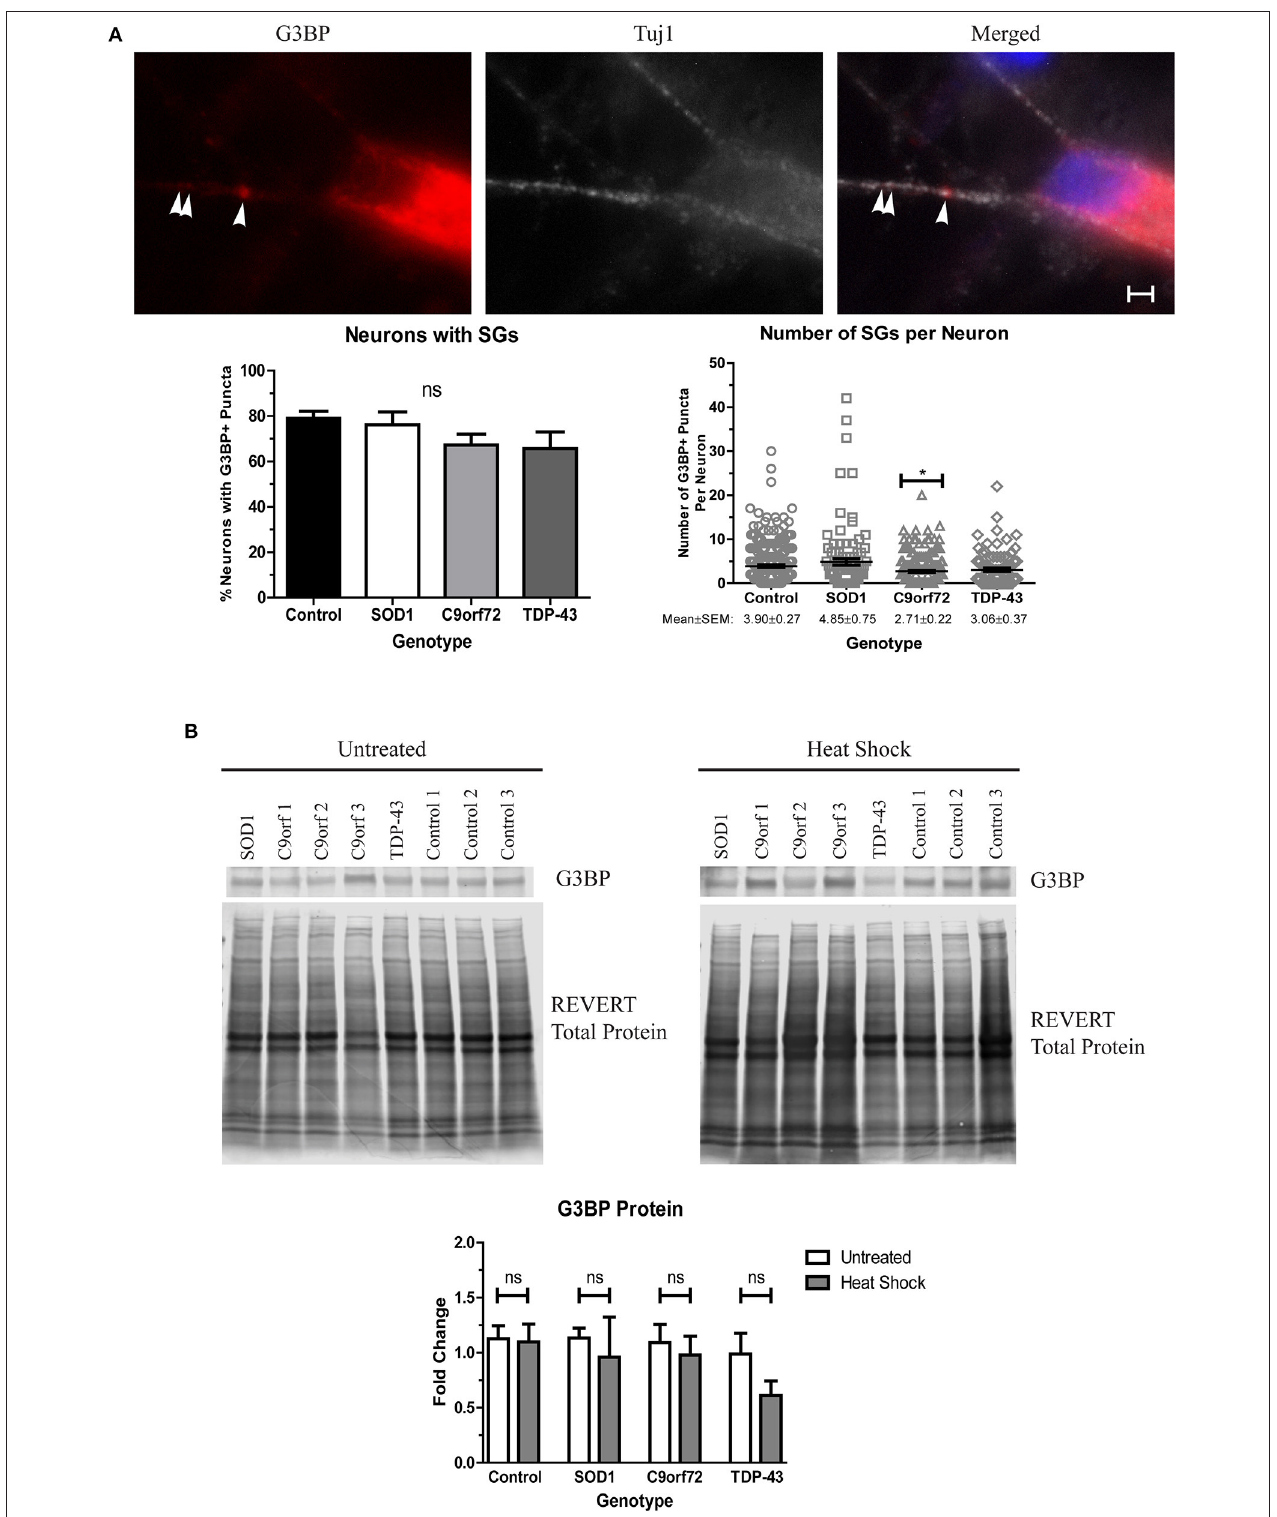
FIGURE 7 | ALS motor neurons do not show enhanced stress granule formation. (A) Immunocytochemistry of Tuj1 (white) and G3BP (red) shows no difference in the number of neurons with at least one G3BP + puncta, but C9orf72 motor neurons exhibit fewer G3BP + puncta per neuron (* p < 0.05 by one-way ANOVA with Tukey post-hoc test). n = 3, scale bar = 2 µ m. (B) Western blot for G3BP shows no difference in protein levels in untreated or heat shocked motor neurons (ns, p > 0.05 by Student’s t -test). Data are normalized to REVERT total protein stain and expressed as a fold change over untreated control samples.